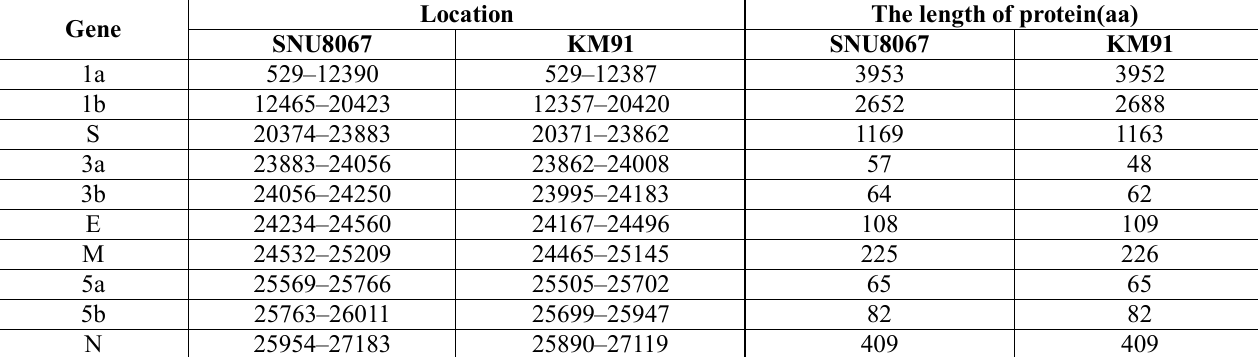
Table 1. Gene of the SNU8067 and KM91 strains in the entire